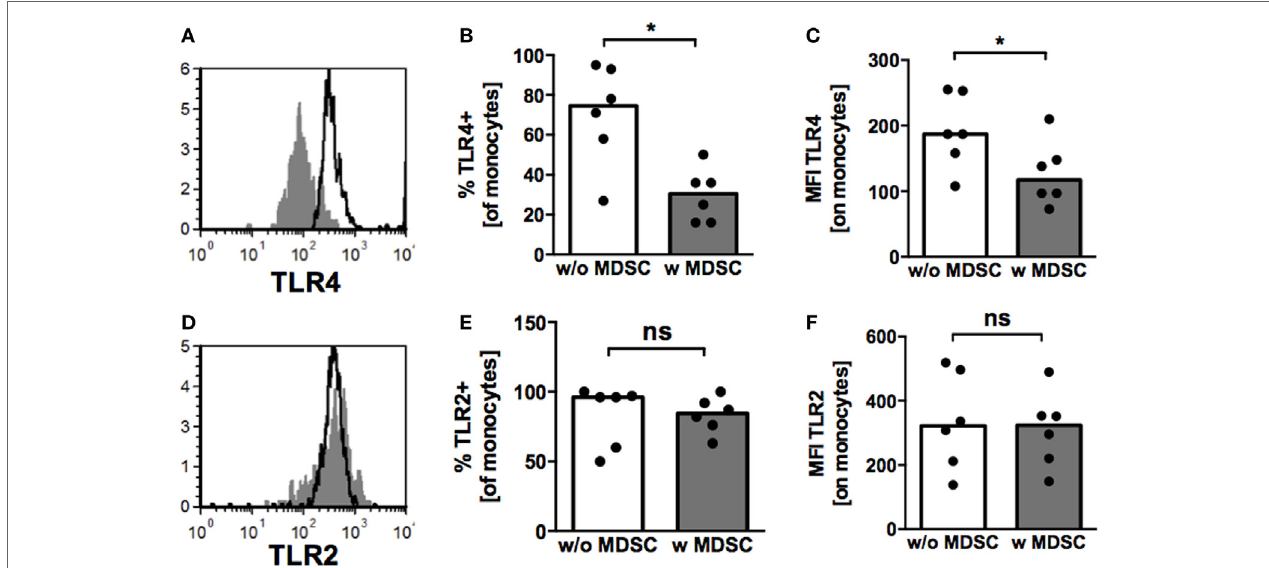
FigUre 4 | Toll-like receptor (TLR)-expression on monocytes under the influence of granulocytic MDSC (GR-MDSC) from breast milk (BM). GR-MDSC were enriched from BM and added to peripheral blood mononuclear cell isolated from a healthy adult control. After 5 days of culture, surface staining for TLR2 and TLR4 was performed and cells were analyzed by flow cytometry. (a,D) Representative histograms of TLR4- (a) and TLR2- (D) expression with (gray histograms) and without (white histograms) addition of GR-MDSC from BM. (B,e) Bar graphs showing the percentage of TLR4- (B) and TLR2- (e) expressing monocytes with (gray bars) and without (white bars) addition of BM-MDSCs. (c,F) Bar graphs showing the MFI of TLR4- (c) and TLR2- (F) expression on monocytes without addition of BM-MDSCs (white bars) and with addition of BM-MDSCs (gray bars). Bars represent pooled data from six independent experiments and each point represents an individual sample. * p < 0.05, ns not significant; Wilcoxon matched pairs signed rank test.